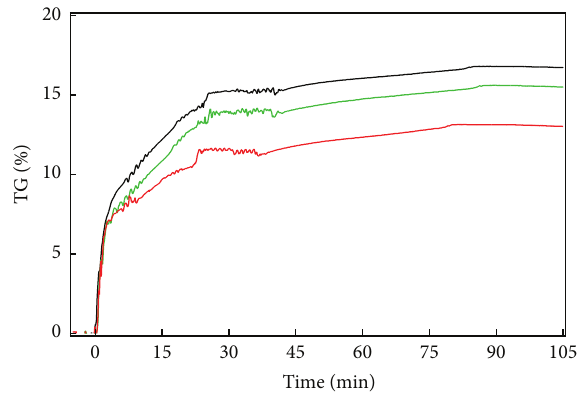
Figure 6: TG curves of carbonation reaction for x CA–KCs. Pore widths: black 7 nm; green 16 nm; red 18